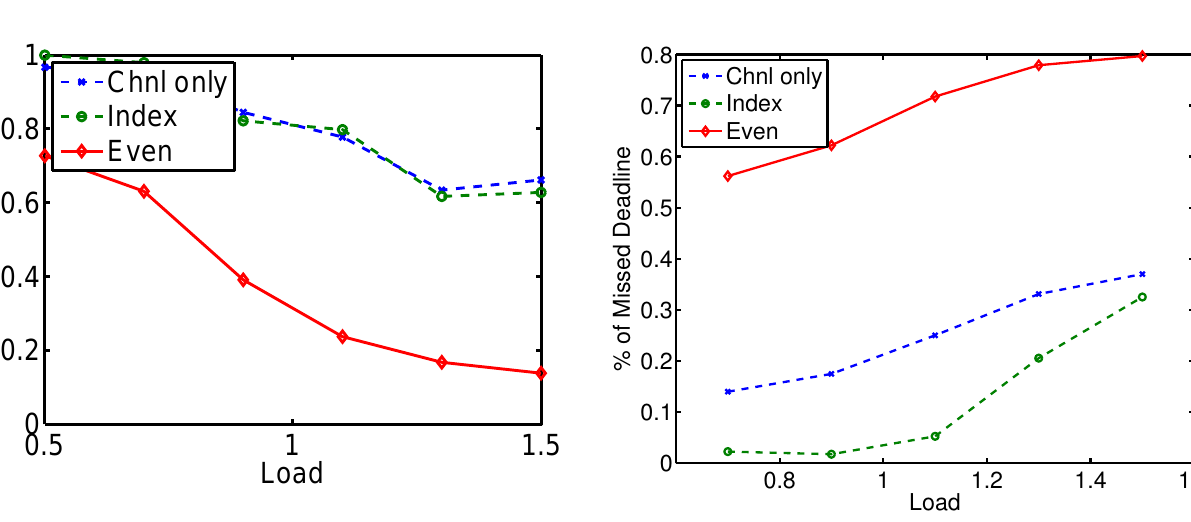
Figure 3. Throughput when Index Policy Objective is Minimizing Average Delay, Real-life Trace